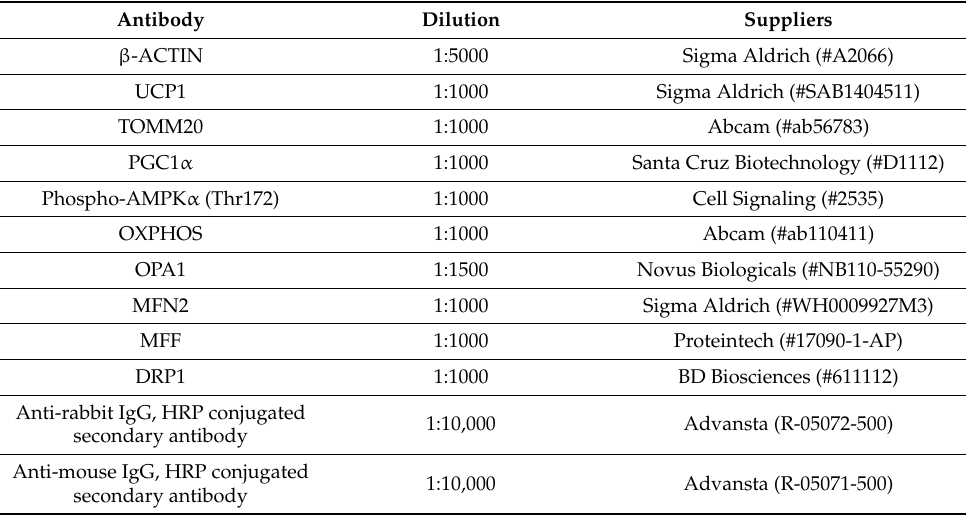
Table 1. List of antibodies used in Western blot